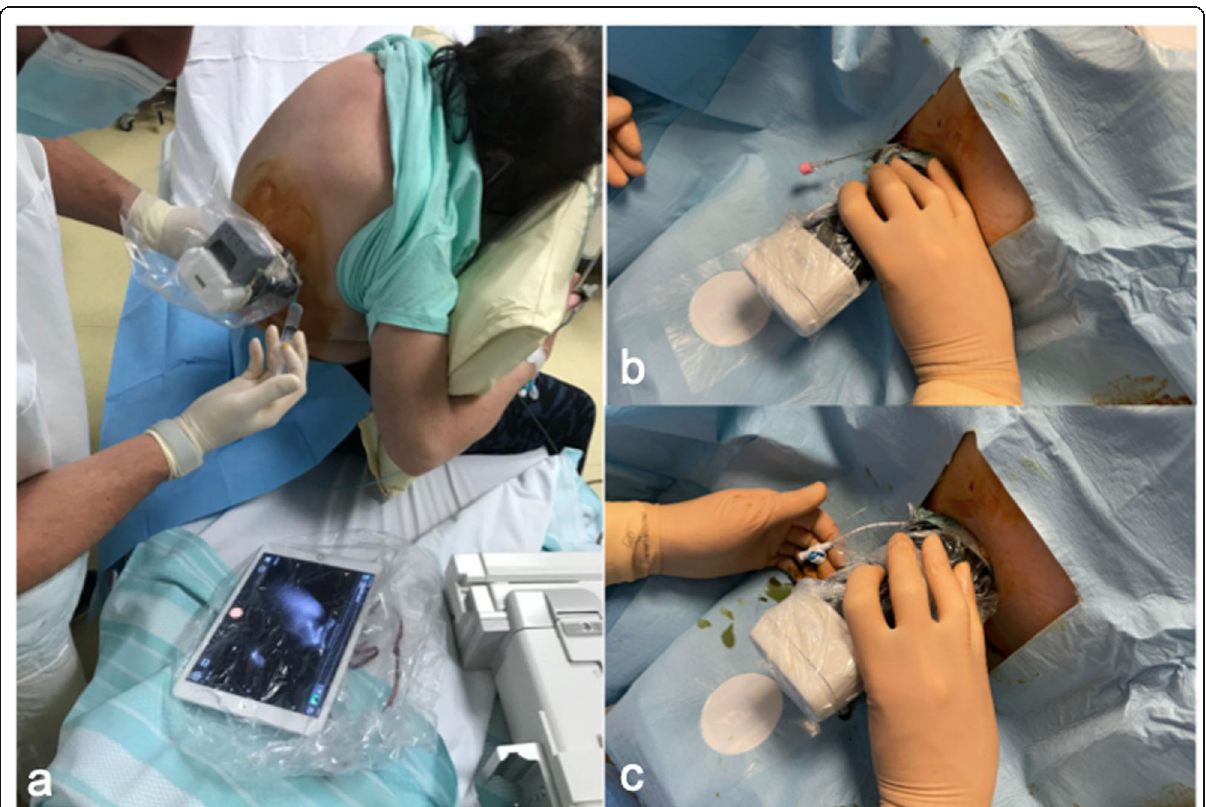
Fig. 2 A low-complexity interventional radiology procedure performed at the patient's bedside using a pocket-sized, wireless-Bluetooth ultrasound system. Images show the diagnostic ultrasound of the right pleural cavity displayed on the tablet ( a ) and the placement of the pleural drainage ( b , c